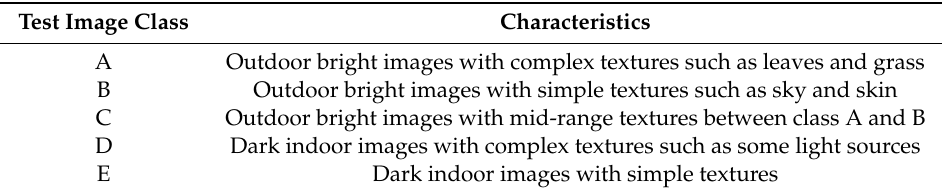
Table 2. Description of test image groups